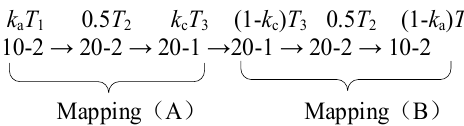
Figure 8. The assigned working time of sex segments.